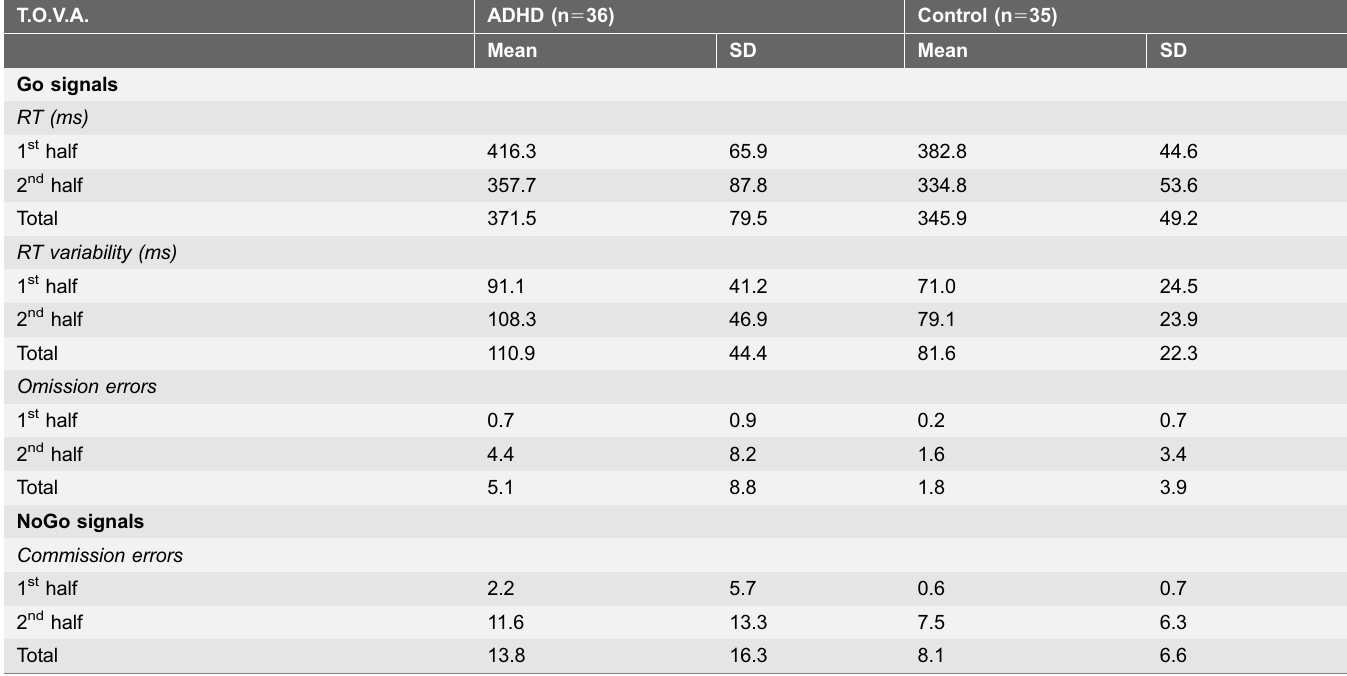
Table 2. Behavioral results on the T.O.V.A. for ADHD patients and healthy controls.